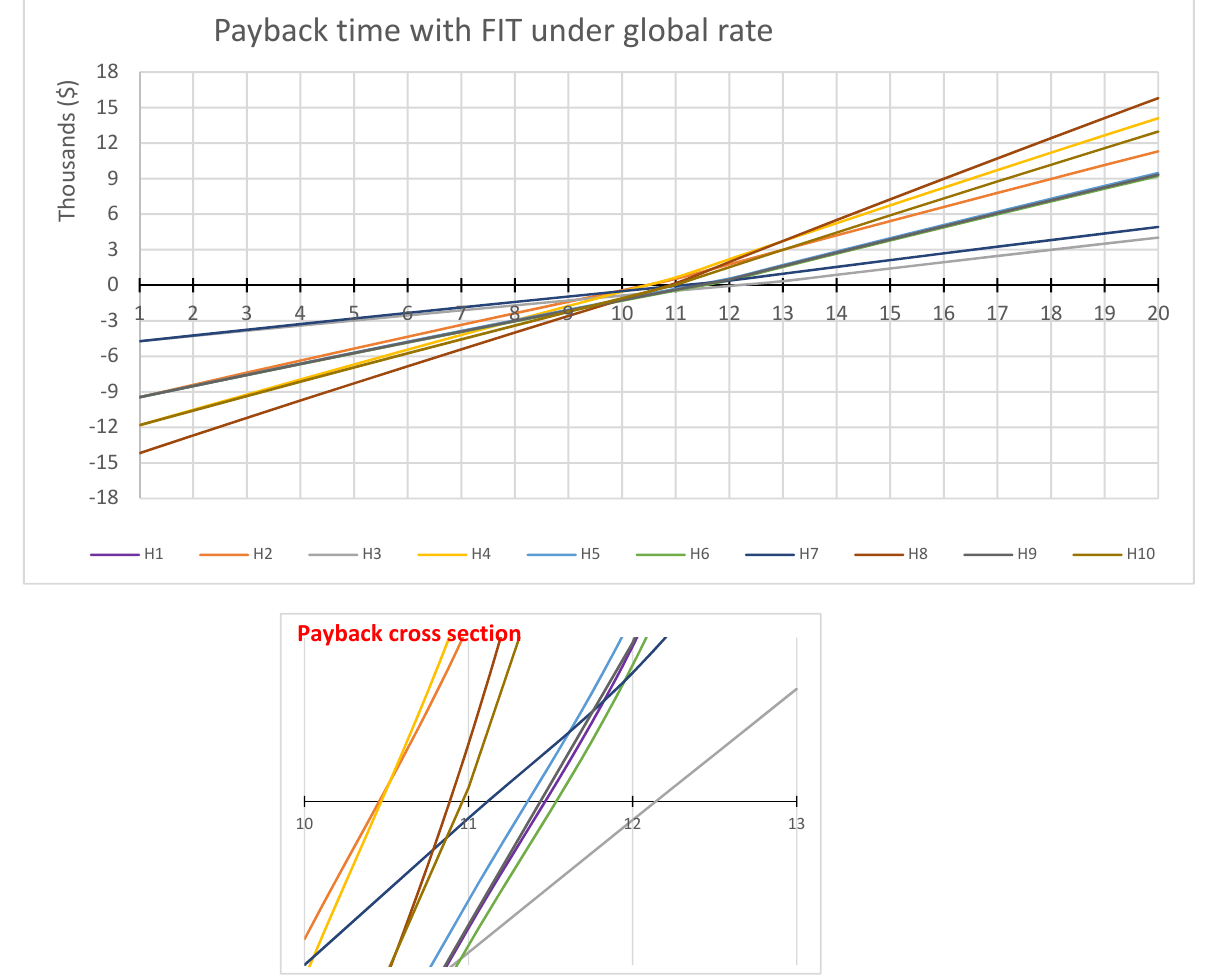
Figure 9. Economic model results demonstrate the payback time for the rooftop PV systems with global electricity rates, FIT with 30% SIP for houses, H1:H10. Table 8. Economic model results demonstrating the economic analysis for the rooftop PV systems with global electricity rates, FIT with 30% SIP for houses, H1:H10.